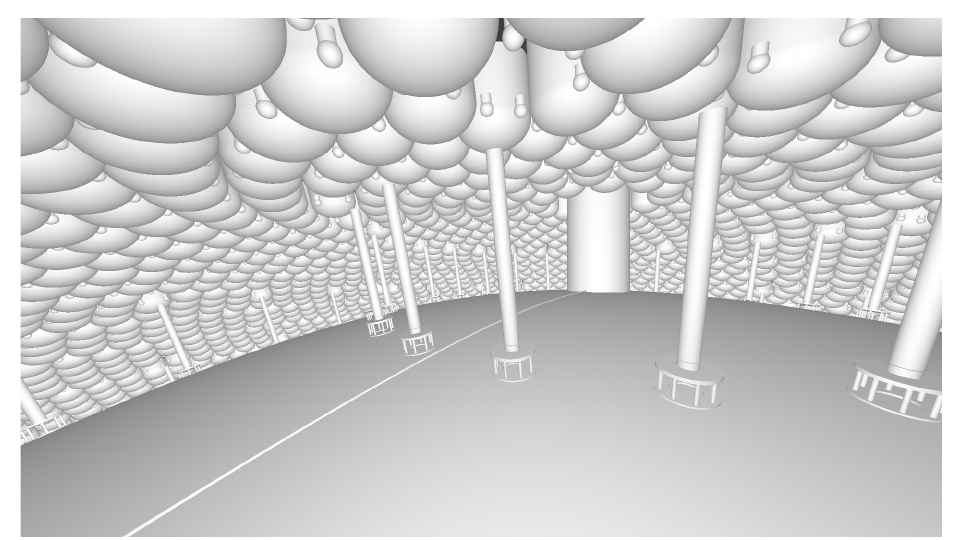
Figure 3. Ray traced rendering of the chimney region of JUNO detector showing photomultiplier tubes, acrylic sphere, supports and the calibration guide tube torus. The rendering uses exactly the same analytic geometry as the simulation. The geometry was directly converted from Geant4 into an Opticks geometry including analytic CSG and persisted into a geometry cache of NumPy[16] binary